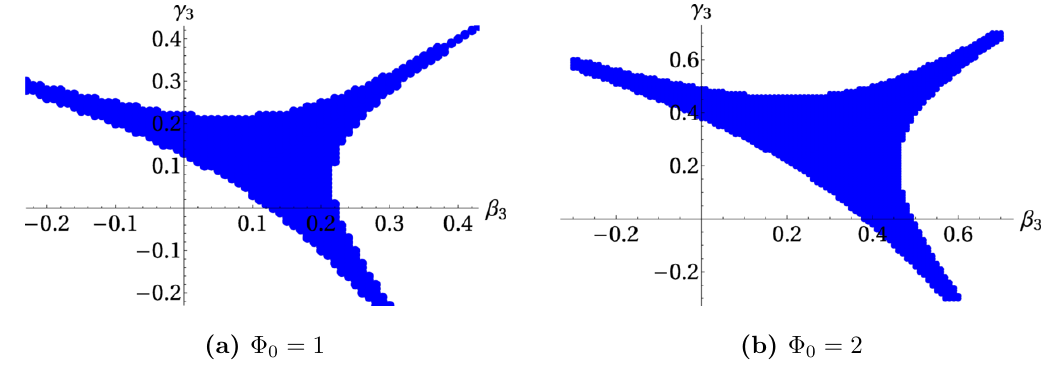
Figure 17. Initial conditions for (cid:13) 3 and (cid:12) 3 that give rise to non-singular solutions for two di(cid:11)erent values of (cid:8) 0